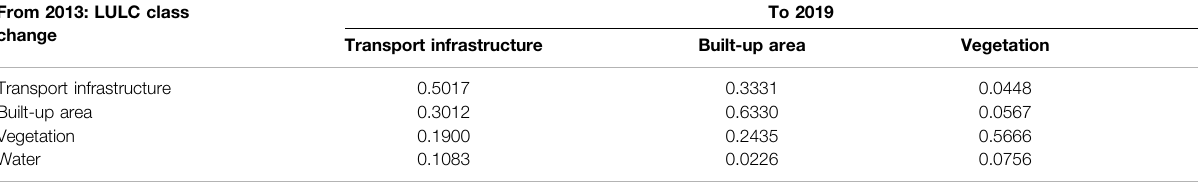
TABLE 6 | Transition probability matrix of LULC changes from 2013 to 2019.